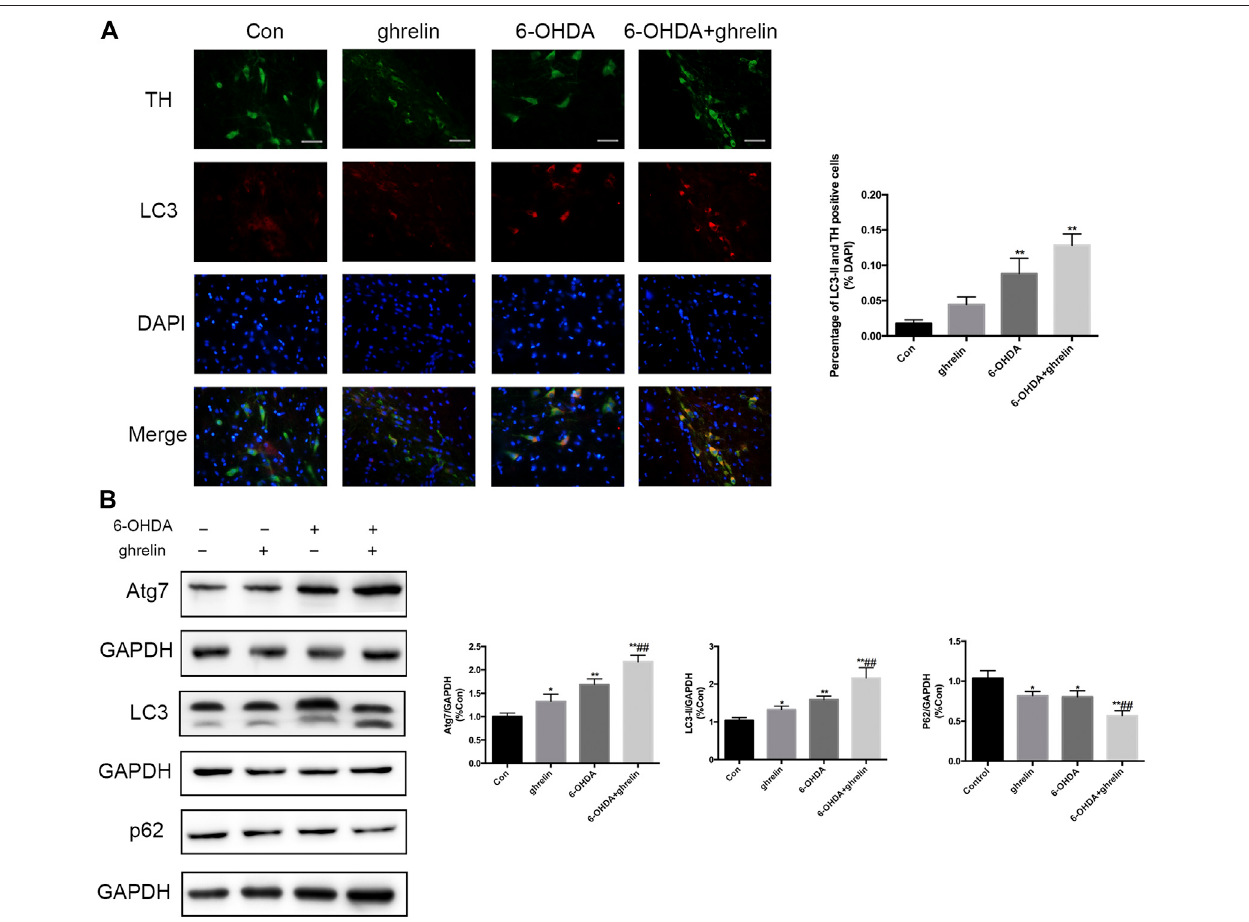
FIGURE2| Ghrelinactivatesautophagyin6-OHDA-inducedPDrats. (A) Representativedoubleimmuno fl uorescencestainingandquanti fi cationforLC3andTHin the right substantia nigra 1 day after 6-OHDA treatment, scale bar (cid:2) 50 μ m. (B) Representative western blot and quanti fi cation of Atg7, LC3 and p62 in the right substantianigra1 dayafter 6-OHDAintoxication;GAPDHwasapplied astheloadingcontrolandforbanddensity normalization.Dataarepresented asmean ± SD;* p < 0.05 vs. the control group, ** p < 0.01 vs. the control group, ## p < 0.01 vs. the 6-OHDA group, n (cid:2) 5.